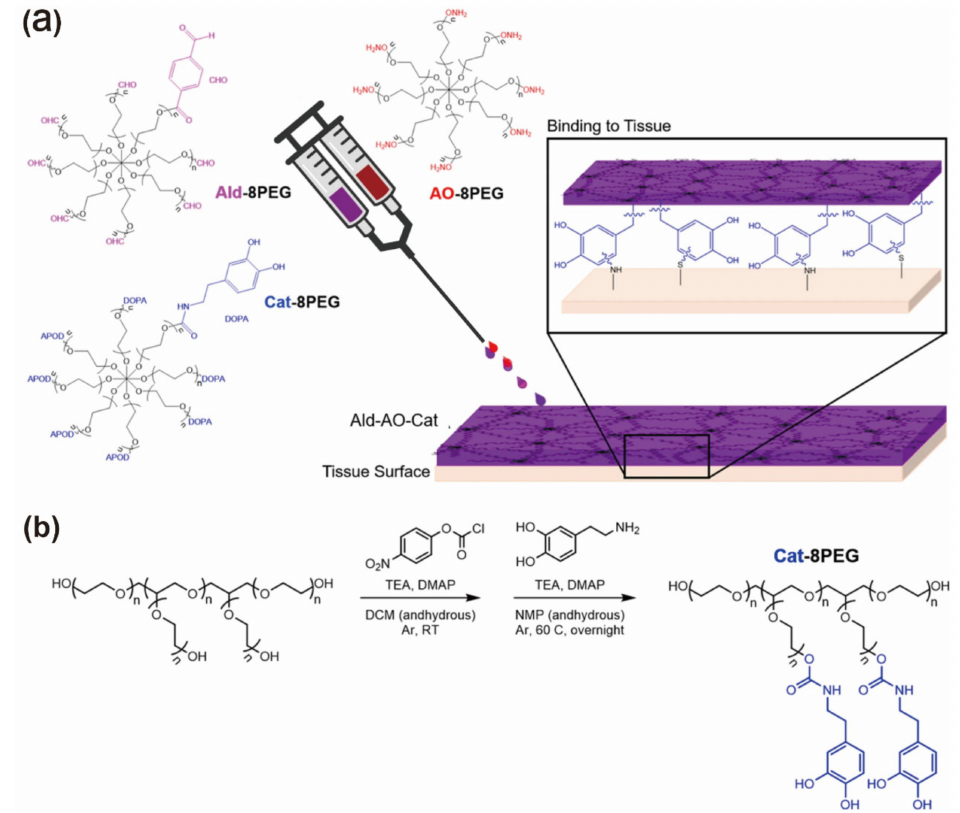
Figure 5. ( a ) Schematic diagram of oxime hydrogel formation using three distinct 8-arm star PEG polymers (AO-8PEG, Ald-8PEG, Cat-8PEG). ( b ) Schematic diagram using a two-step method to synthesize the Cat-8PEG. Reprinted with permission from Ref. [142]. Copyright 2021 The